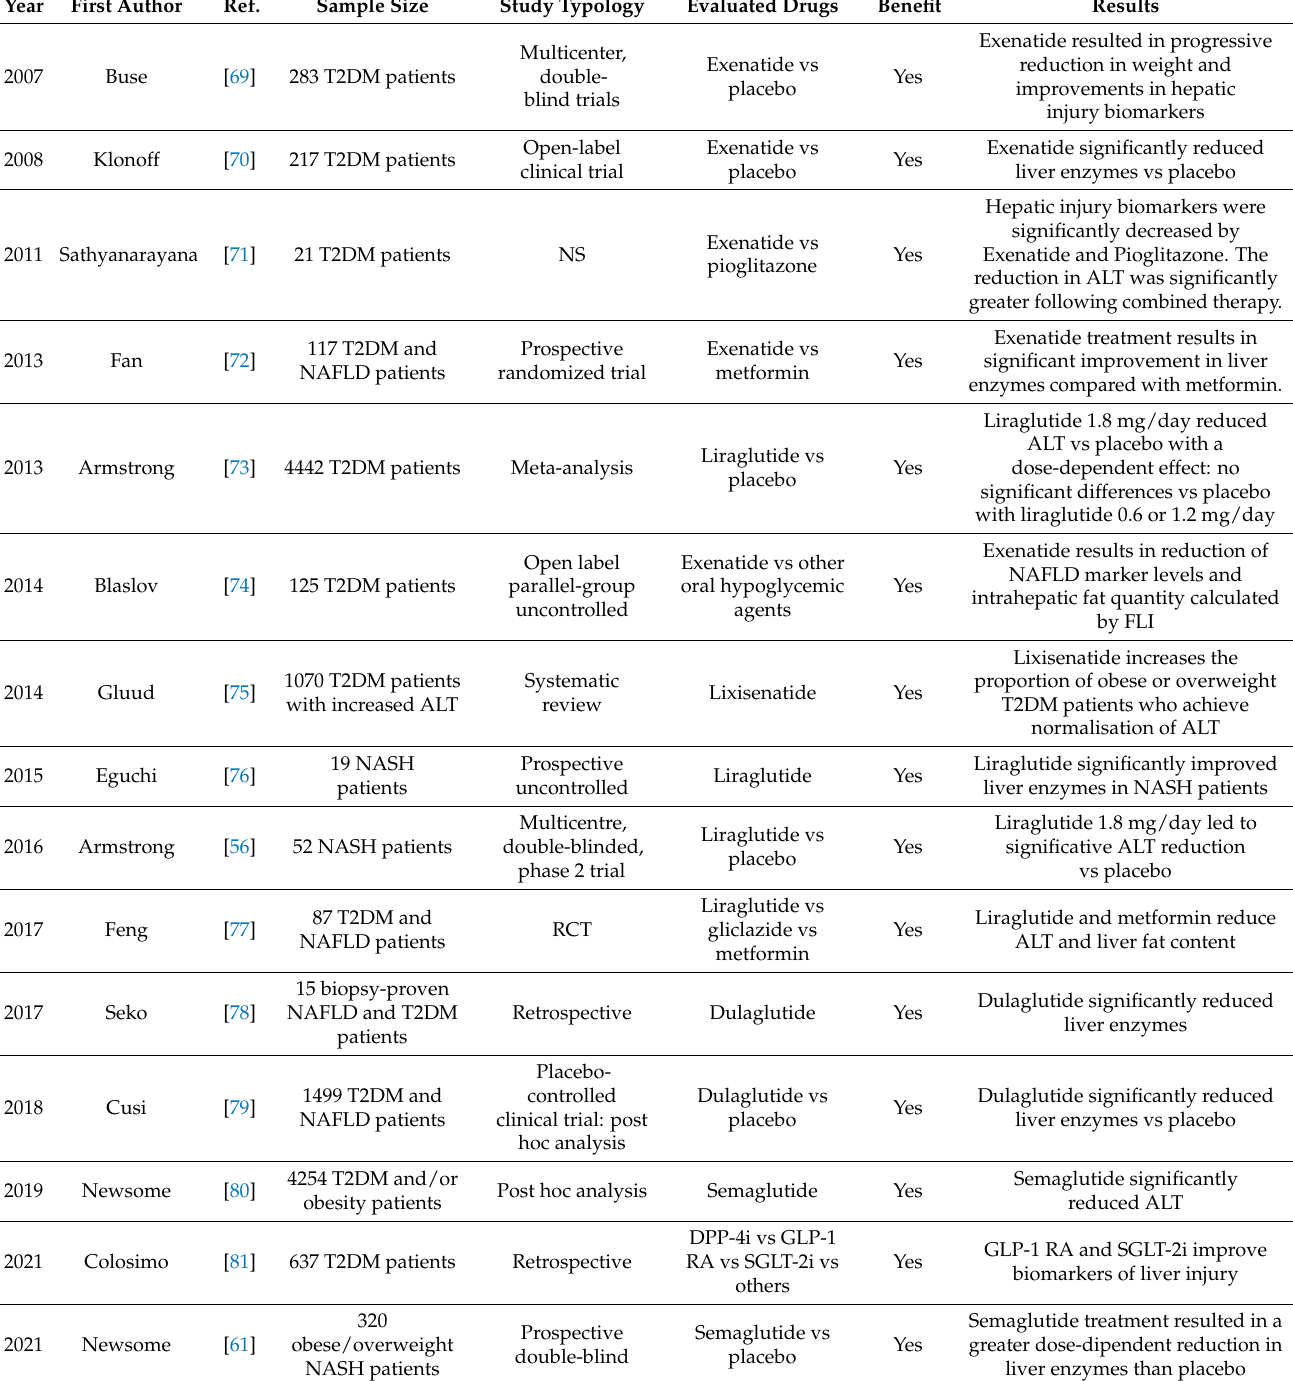
Table 2. Main evidences on the effect of GLP-1 RA on liver injury